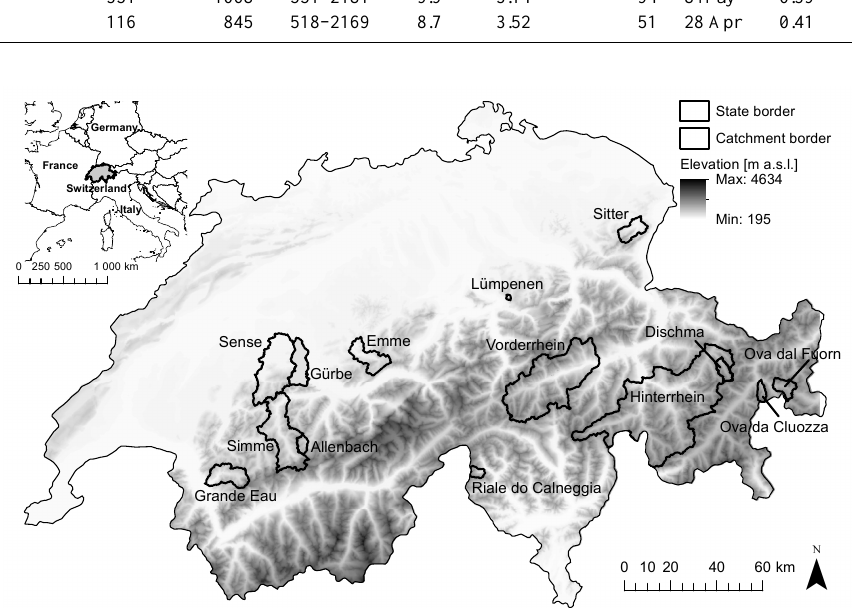
1577 km 2 (Fig. 1 and Table 1). Catchments as close as pos- sible to natural conditions were selected, i.e. streamflow is near-natural and no major human influences such as dams